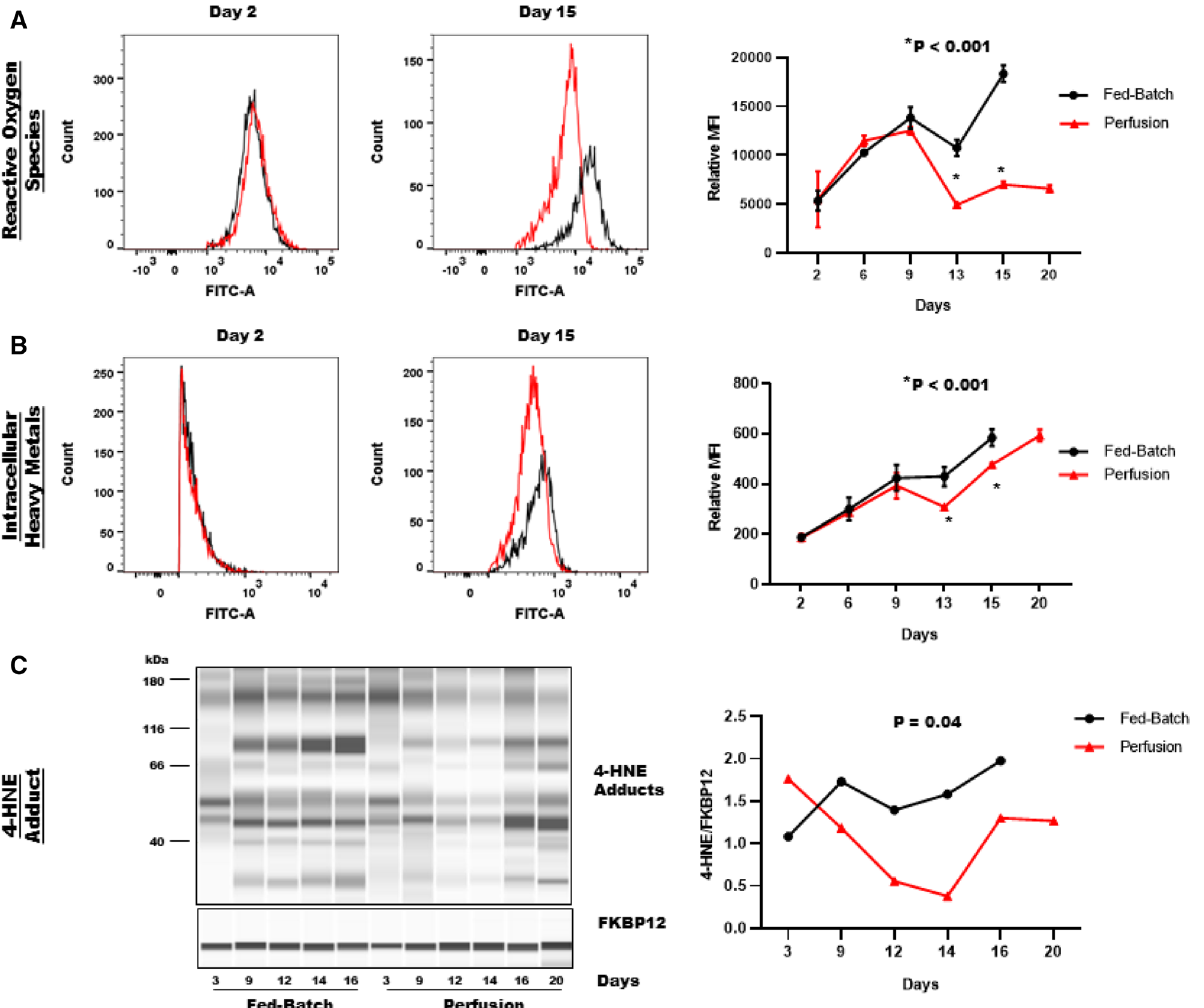
Figure 3. Comparison of intracellular oxidative-stress between fed-batch and perfusion bioreactors. Cell samples were taken on the indicated days to determine intracellular changes in ( A ) reactive oxygen species (ROS), ( B ) heavy metal ions and ( C ) 4-HNE adducts formation. ( A , B ) Representative histograms for a fed-batch and a perfusion bioreactor on day 2 and day 15 are shown in the left panel. Mean fluorescence intensity (MFI) from duplicate bioreactors are shown in the right panel. Data are expressed as mean ± SD. ( C ) Representative capillary western blot image for 4-HNE adduct formation in a fed-batch and a perfusion bioreactor is shown in the left panel. FKBP12 (~ 12 kDa) was used as loading control. Data is expressed as 4-HNE AUC/FKBP12 AUC in the right